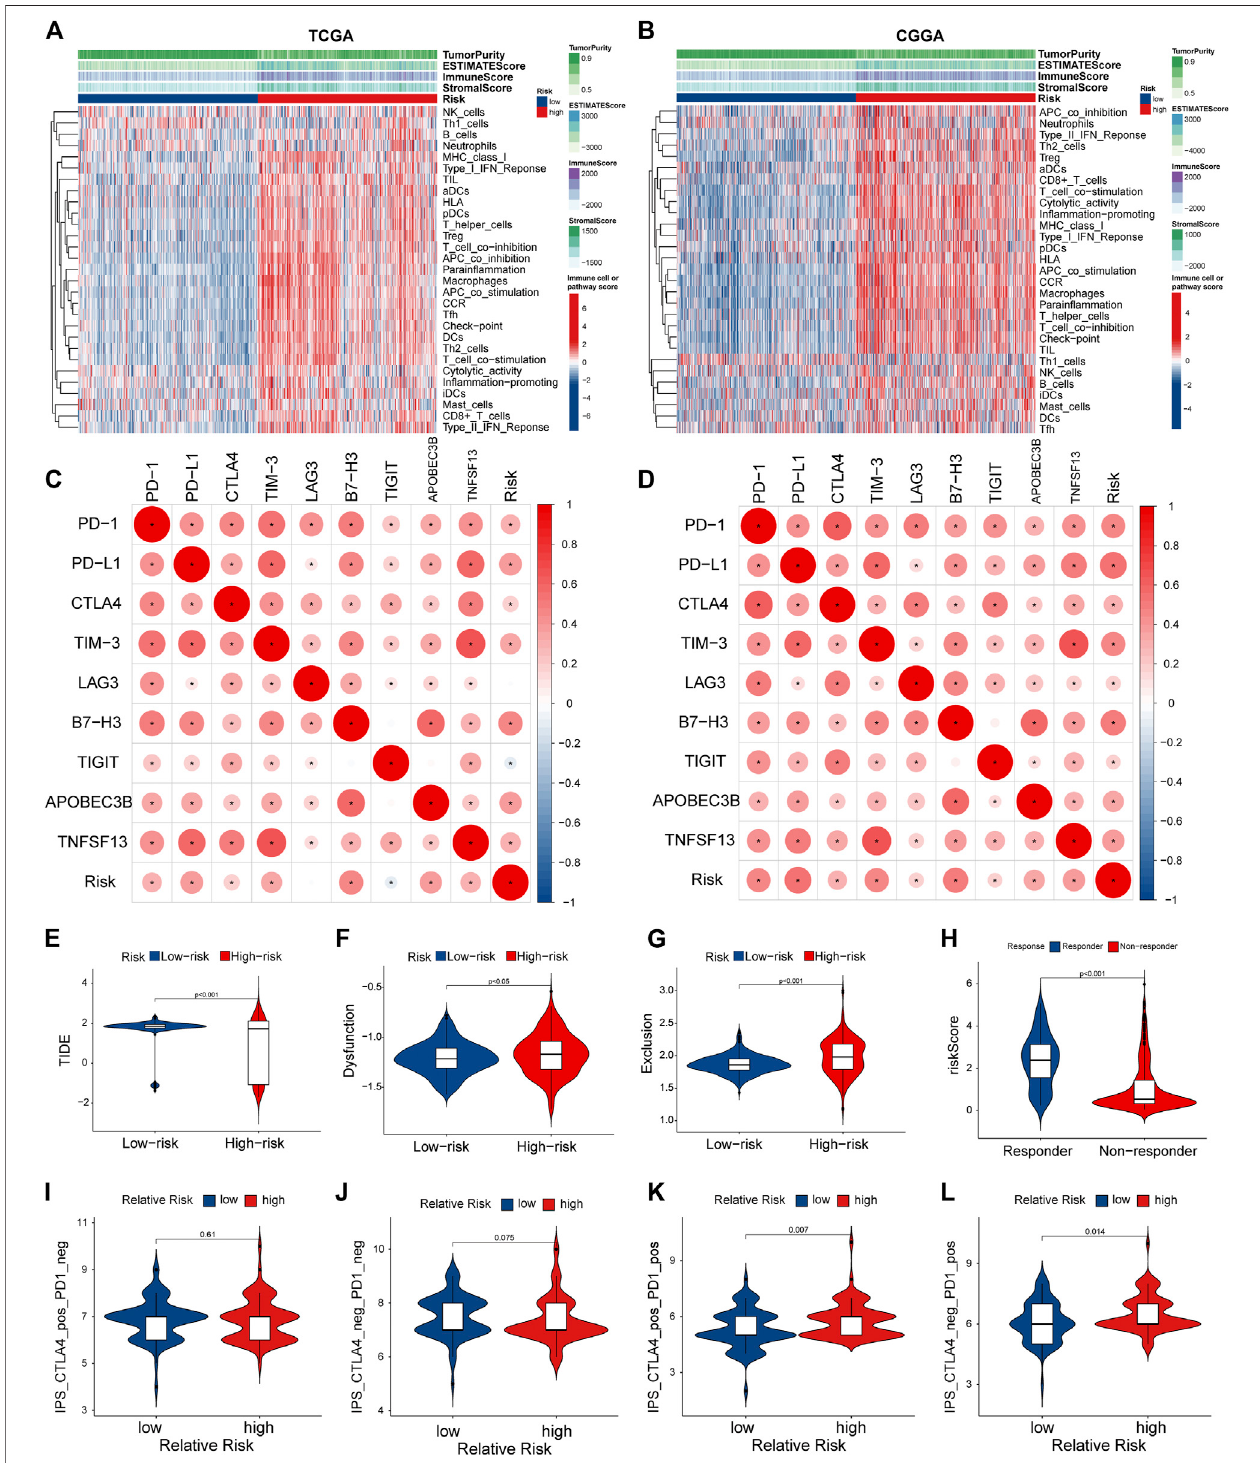
FIGURE 8 | Tumor microenvironment and immunocorrelation analysis of PRGs signature risk group in glioma. (A,B) Heatmap of correlation between different risk group and different immune in fi ltration pattern using ssGSEA in TCGA (A) and CGGA (B) . (C,D) Correlation analysis between PRGs risk score and expression levels of immunecheckpoints(PD1,PD-L1, CTLA-4,LAG-3,TIM-3,B7-H3, TIGIT,APOBEC3B, andTNFSF13)inTCGA (C) andCGGA (D) . (E – H) Correlationanalysisbetween TIDE evaluation in TCGA(LGG-GBM) datasets. TIDE score (E) , dysfunction score (F) , Exclusion (G) and Responder (H) . (I – L) Correlation analysis between immunophenoscore of anti-cytotoxic T-lymphocyte antigen-4 (CTLA-4) and anti-PD-1 blocker and Relative risk of TCGA-GBM datasets. TIDE, Tumor Immune Dysfunction and Exclusion. PRGs, Pyroptosis Related genes. TCGA, The Cancer Genome Atlas. CGGA, Chinese Glioma Genome Atlas. ssGSEA: single sample gene set enrichment